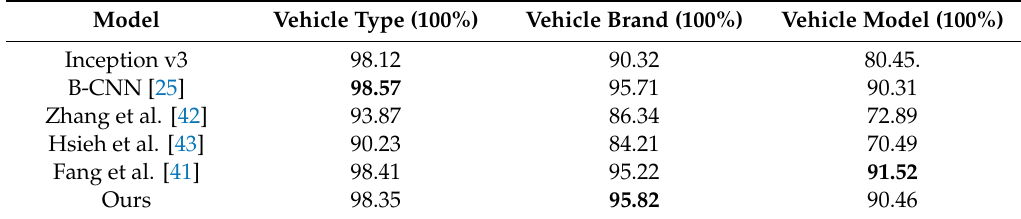
Table 6. Di ff erent levels of vehicle label recognition